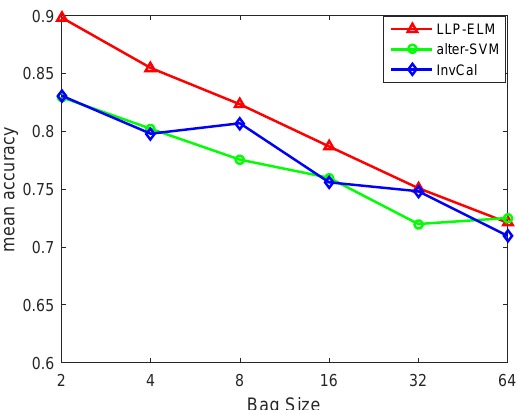
Figure 4. The mean accuracies for the classification of different methods on the machine learning datasets. Specifically, the x-axis represents different bag sizes and y-axis is the mean accuracy. Furthermore, different algorithms are denoted by different colors.